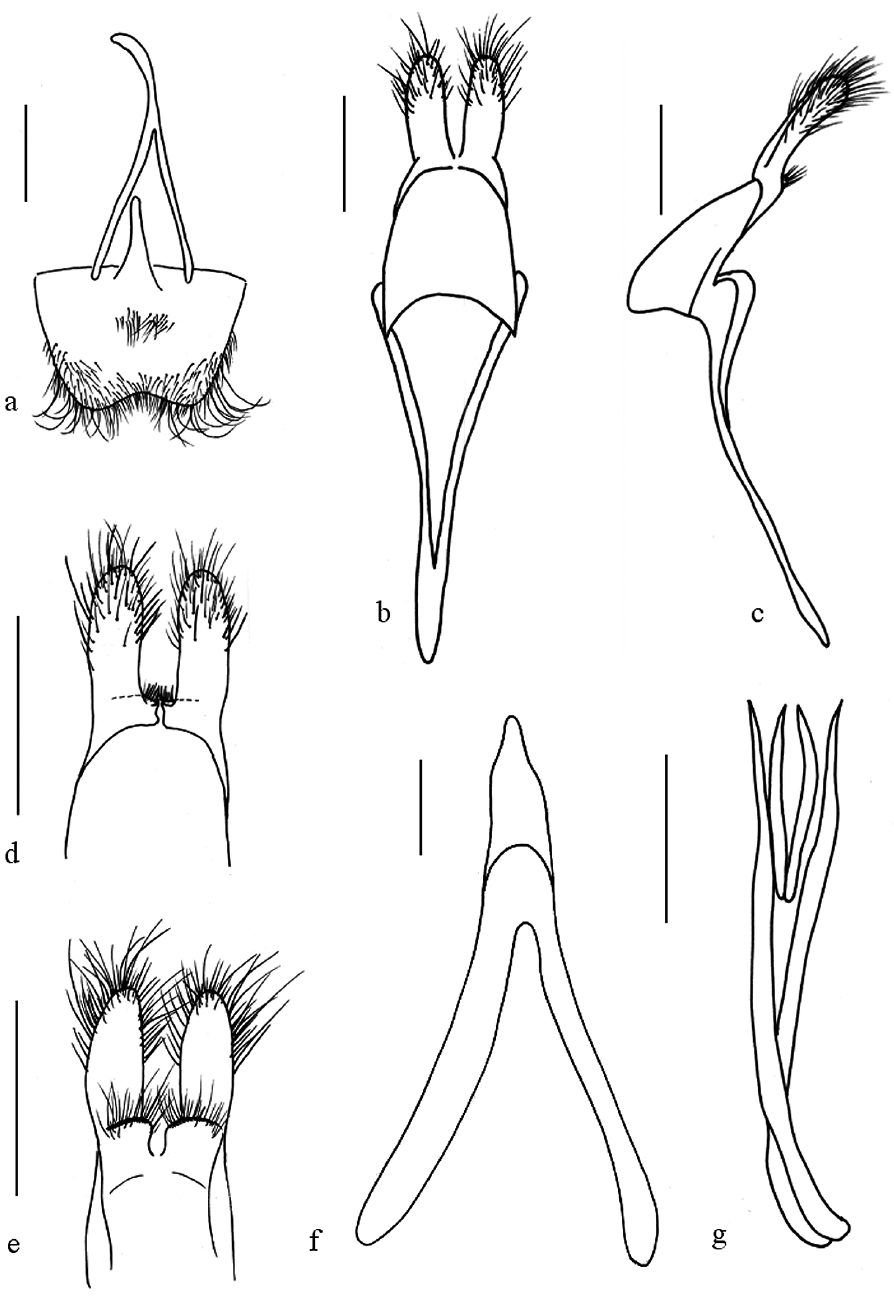
Figure 8. Oberea sylvia , male genitalia, a tergite viii b tegmen, dorsal view c tegmen, lateral view d para­ meres, dorsal view e parameres, ventral view f median lobe, ventral view, g sclerities in endophallus. Scale bar 0.5